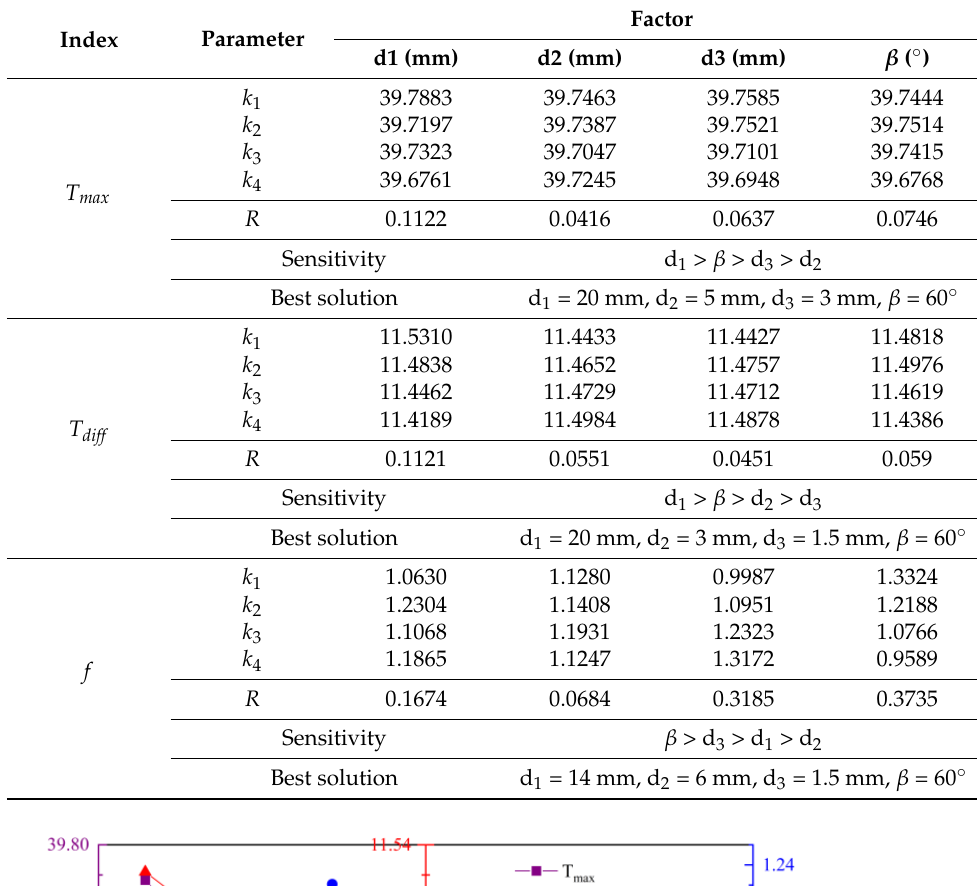
Table 5. Range analysis results.